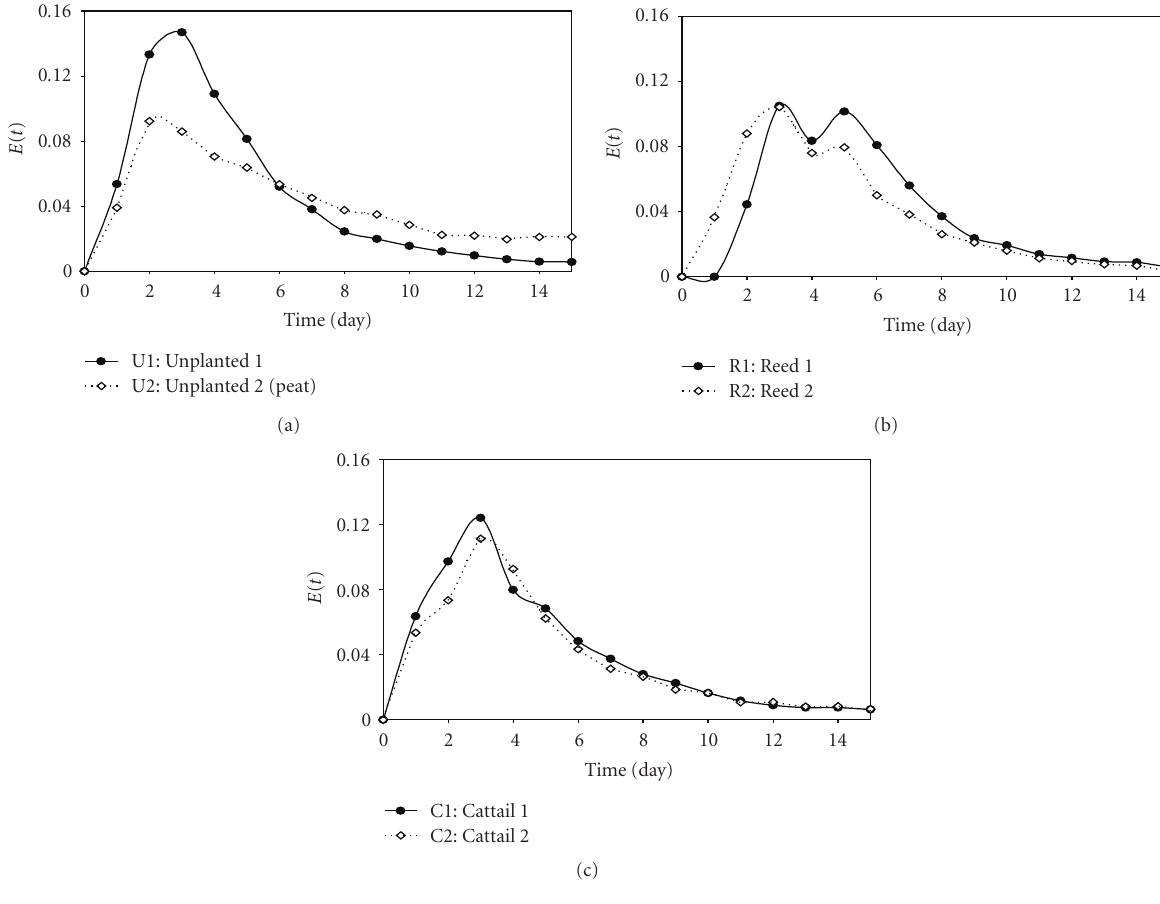
Figure 3: Response curves of the di ff erent pilots.